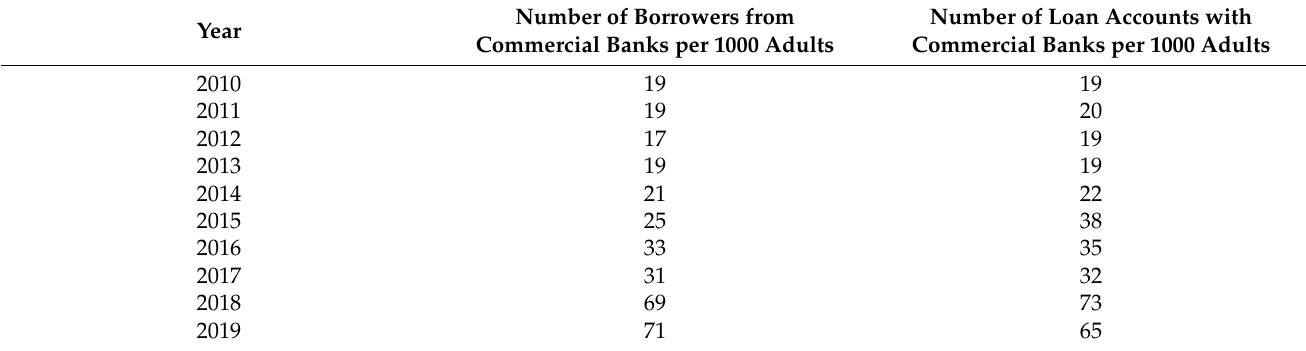
Table 5. Borrowers and loan accounts with commercial banks from commercial banks per 1000